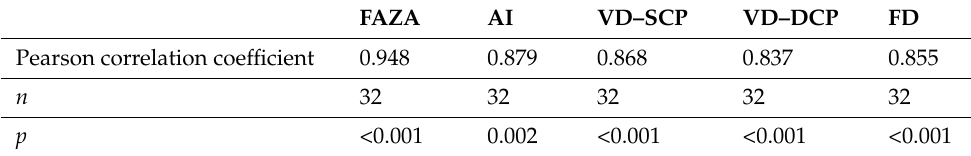
Table 3. Inter-eye correlation using Pearson’s correlation coefficient.